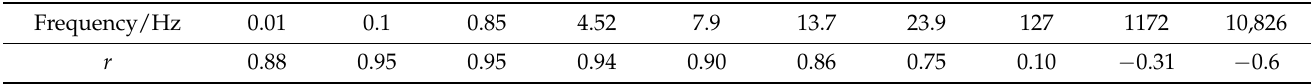
Table 4. Pearson’s correlation coefficient ( r ) between the phase angles and | Z | 0.01Hz for T700/VE. Frequency/Hz